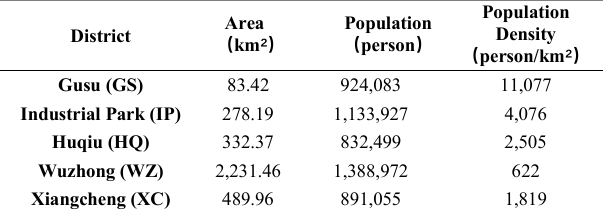
Table 1. Area, population and population density by district